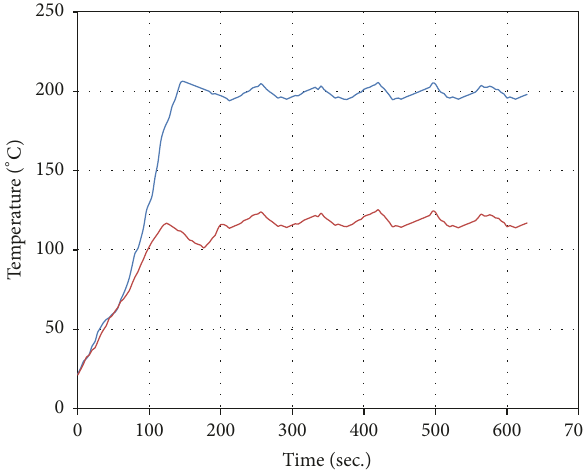
Figure 3: Temperature time histories for preheated specimens.